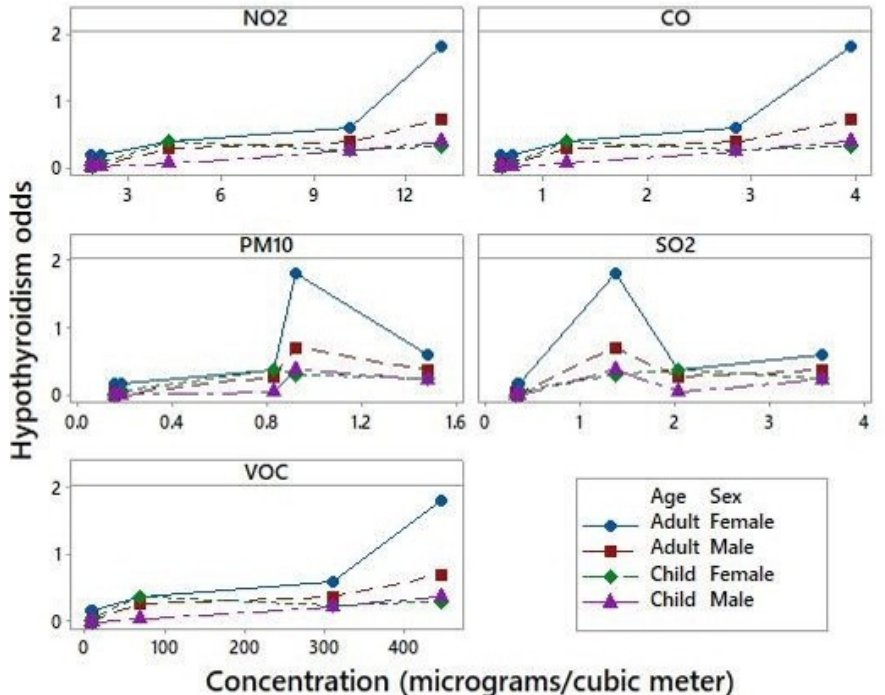
Figure 2. Scatterplots showing the Hypothyroidism odds related to NO2, CO, PM10, SO2, and VOC